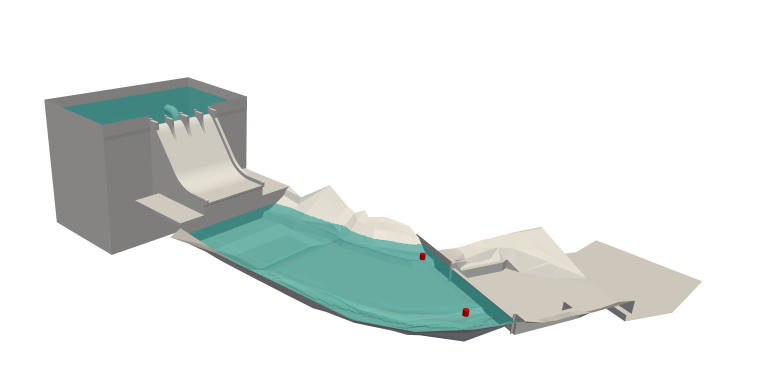
Figure 5. Initial condition of the water level for the configuration with the secondary dam. The two virtual hydrometers used to compare the water level with the experiments upstream of the secondary dam are shown in red.